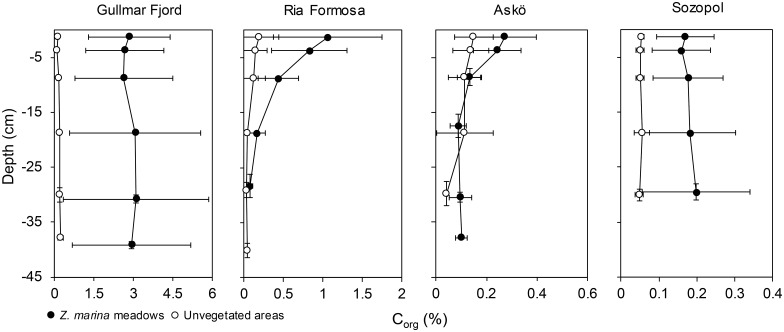
Organic carbon depth profiles.Mean sedimentary carbon (% Corg ± SD) depth profiles grouped for the different areas showed as mean slice depth. Note that the scale on the x-axes vary among the different depth profiles due to large variation in carbon content among areas.